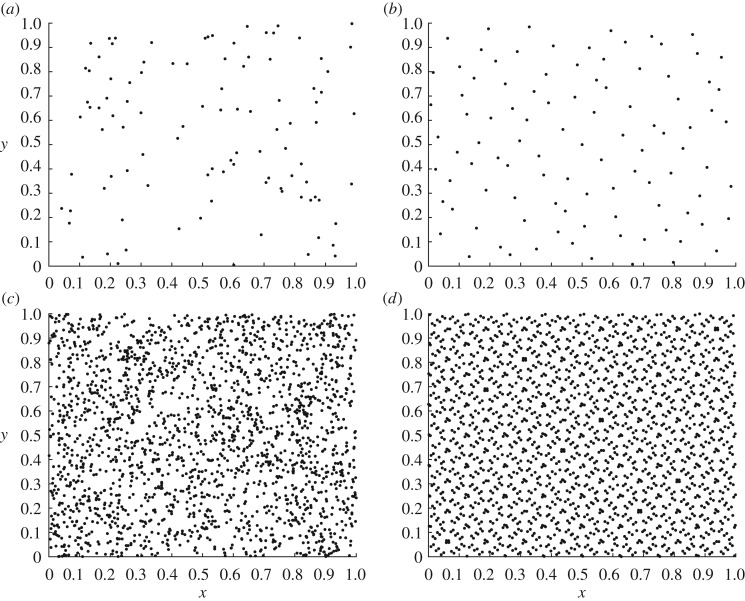
Various pseudo-random and Sobol sequences sampling over the unit square. (a) 100 and (c) 2000 two-dimensional pseudo-random numbers generated uniformly over the unit square. (b) 100 and (d) 2000 two-dimensional numbers generated by Sobol sequences over the unit square.